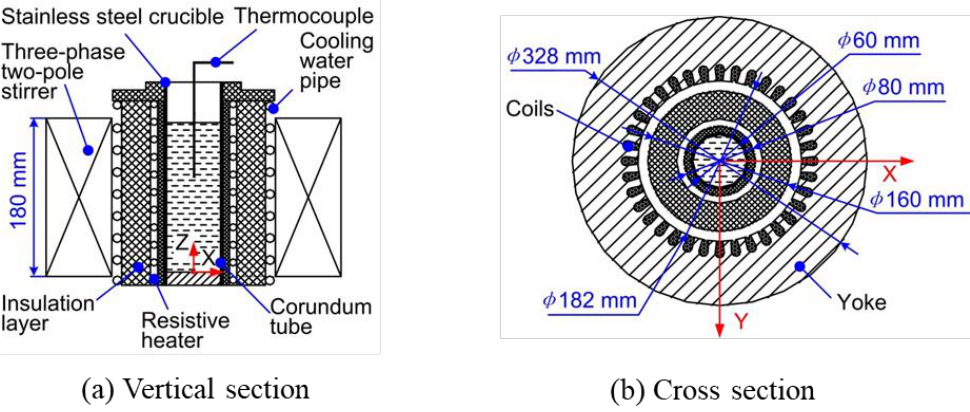
Figure 2. Geometric model of the electromagnetic stirrer.